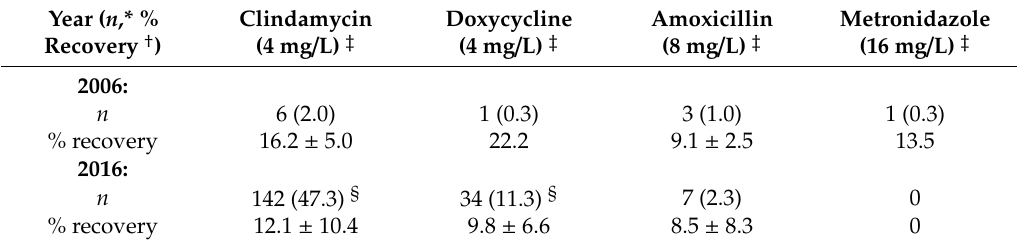
Table 1. Patients with subgingival P. micra resistant in vitro to antibiotic breakpoint